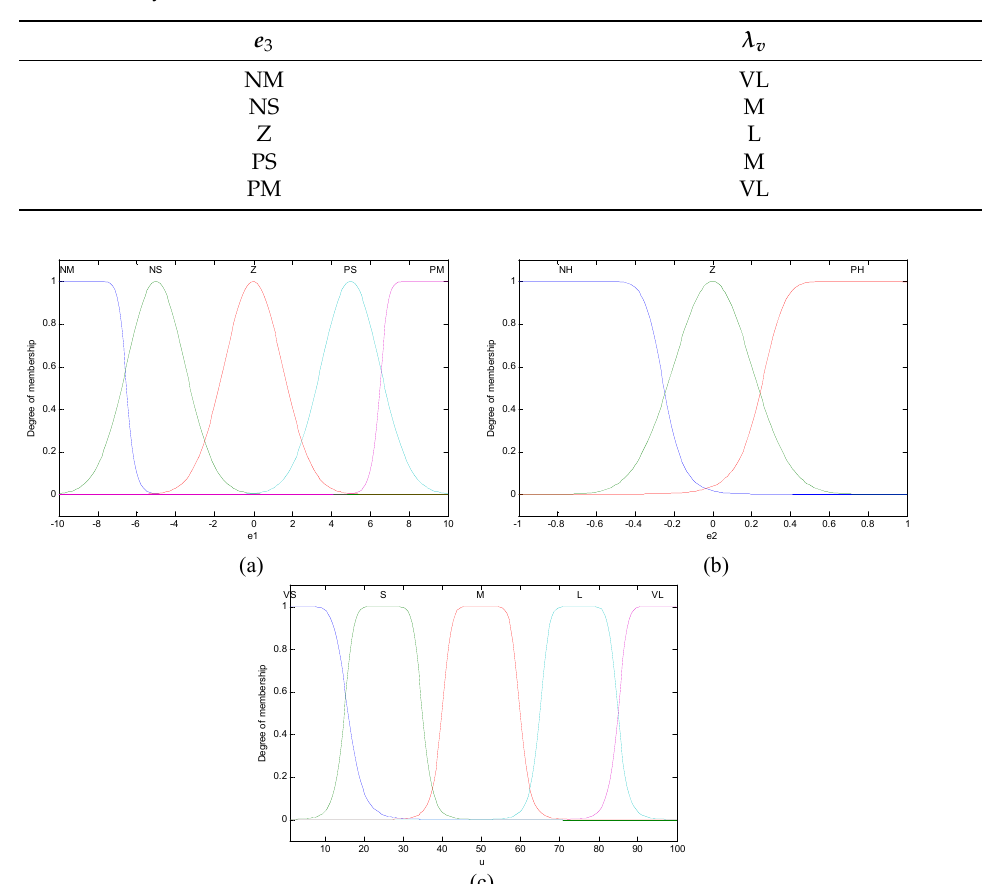
Table 2. Fuzzy rules for λ v .